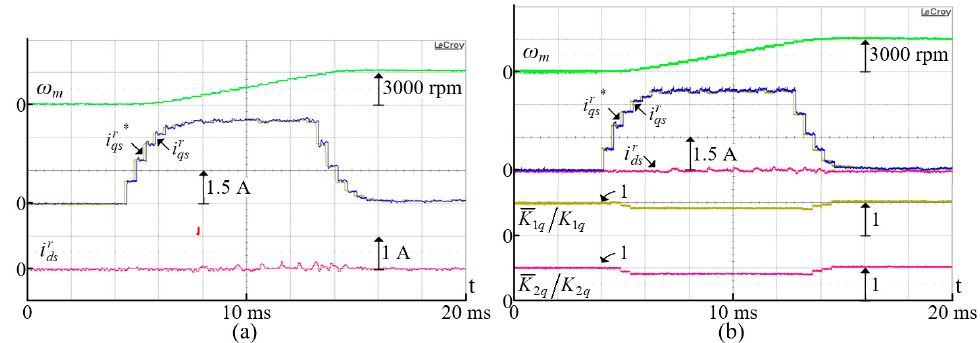
Figure 23. The amplified current response in the acceleration region of Figure 23 with ˆ L qs = L qs when the online current loop tuning is ( a ) de-activated and ( b )